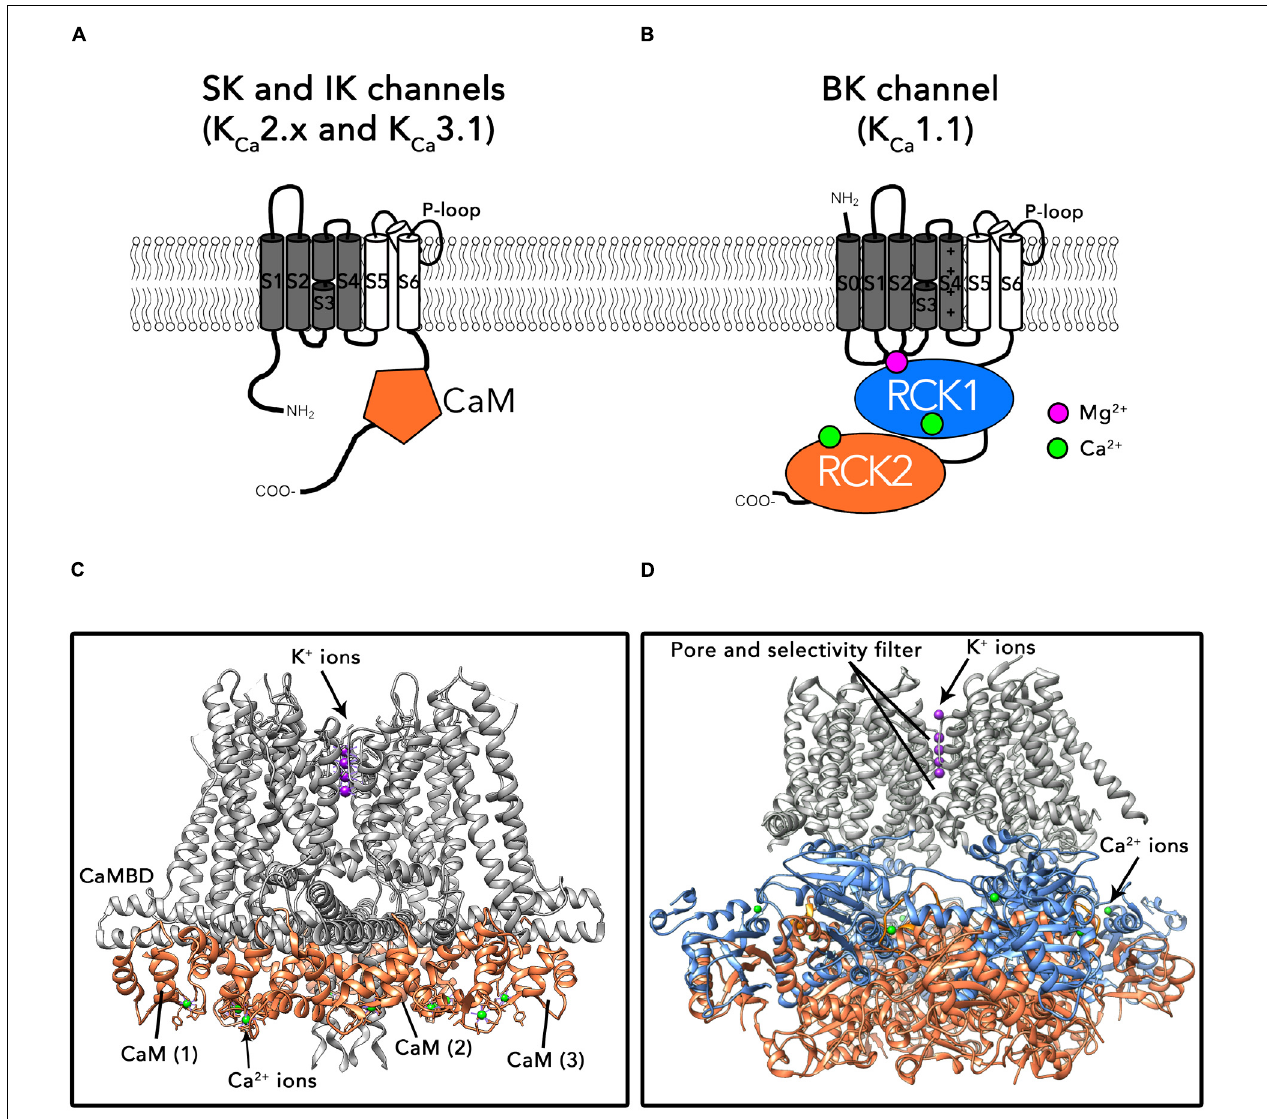
FIGURE 1 | Topology and structures of SK/IK and BK channels. (A) Schematic protein topology of one SK α -subunit including the CaM bound to the CaMBD (represented as an orange hexagon). (B) Full-length structure of the Ca 2 + -CaM bound IK channel (PDB: 6CNN). The CaM N-lobe binds Ca 2 + ions after association of CaM to the SK channel C-lobe. (C) Schematic topology of one BK α -subunit. Binding sites for divalent cations are located in the cytosolic C-terminal region of the channel. Each α subunit contains two high affinity Ca 2 + binding sites (represented as green circles) and one low affinity Ca 2 + and Mg 2 + binding site, formed by residues from RCK1, S0–S1 and S2–S3 intracellular loops (purple circle). (D) Ca 2 + -bound BK α homotetramer full-length structure from Aplysia californica (PDB: 5TJ6).